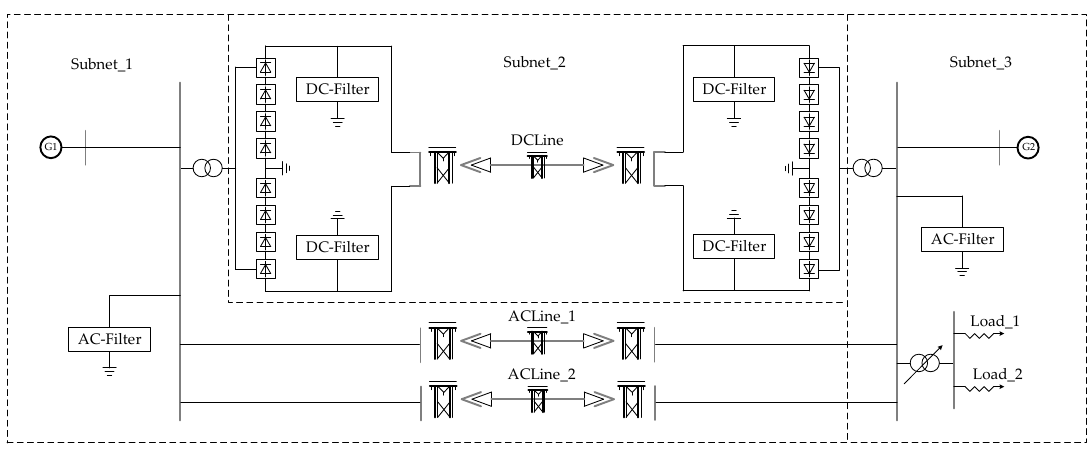
Figure 4. Standard test model.